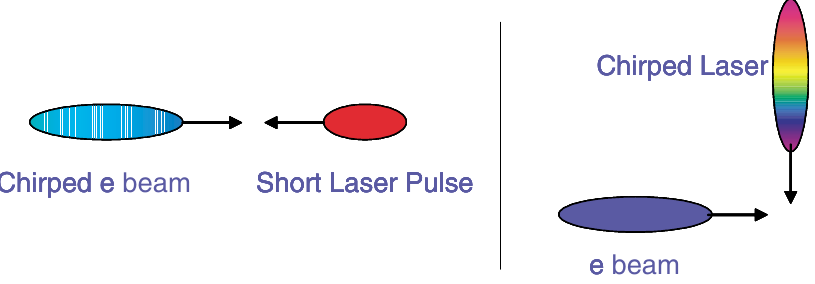
FIG. 12. (Color) Methods for chirped x-ray pulse production.